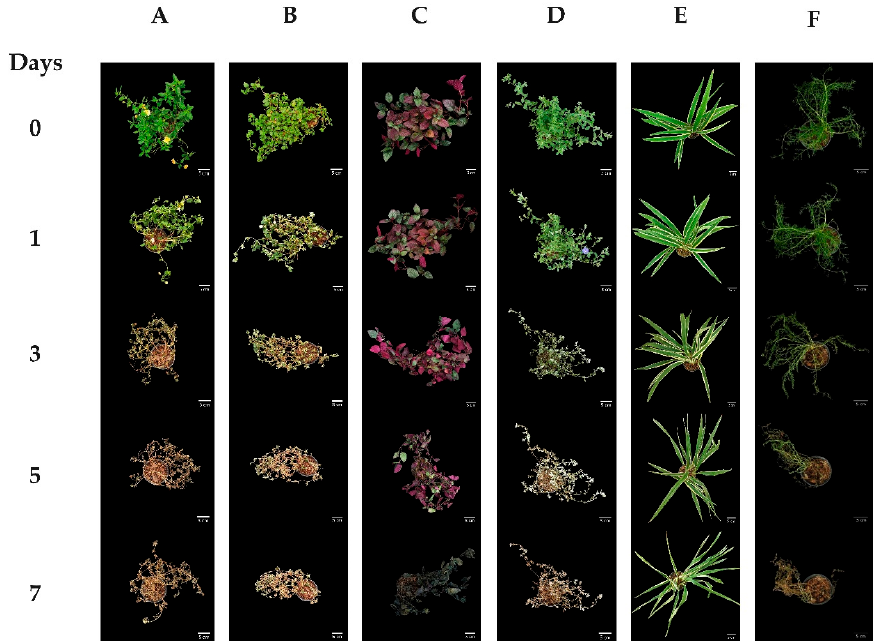
Figure A2. Images of plants under the drought treated conditions at 5 time intervals: 0, 1, 3, 5, and 7 days after the start of the experiment ( Lantana camara : A , Heterocentron elegans : B , Hemigraphis alternata : C : Convolvulus sabitus : D , Dianella caerulea : E , Achillea millefolium. Horticulturae 2020 , 6 , x FOR PEER REVIEW